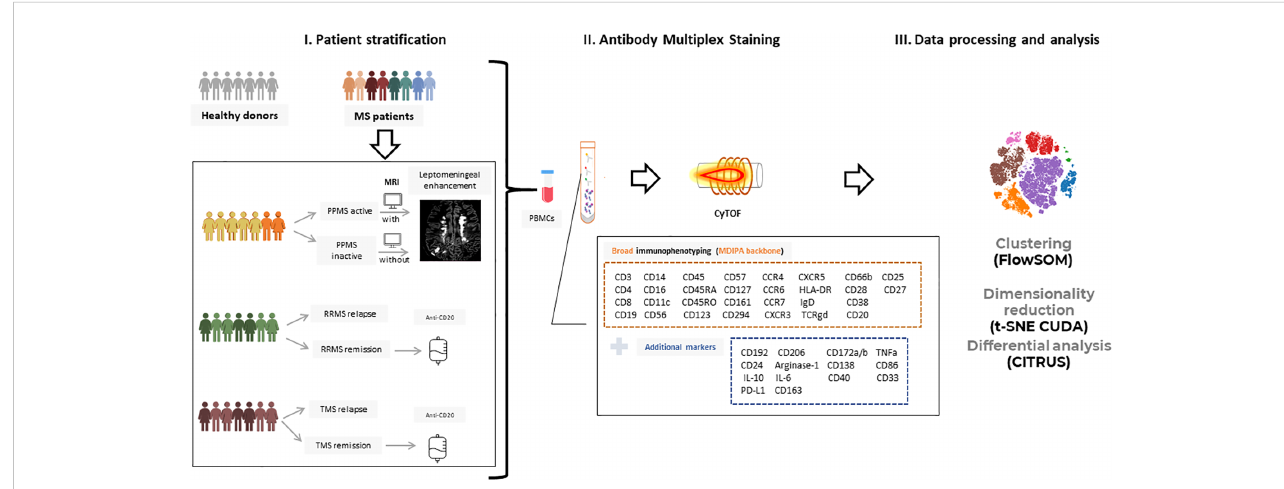
FIGURE 1 Experimental setup and work fl ow for mass cytometry analysis. (I) Peripheral blood mononuclear cells (PBMCs) from patients with Multiple Sclerosis (n=32; PPMS=8, RRMS=10, TMS=14) and healthy donors (n=10) were isolated and further strati fi ed in more subgroups based on clinical and radiological criteria. RRMS and TMS were subgrouped based on disease activity in those during a clinical relapse (RRMS; n=5, TMS; n=5) and those under remission (RRMS; n=4, TMS; n=5). PPMS were subgrouped based on the presence of leptomeningeal enhancement on MRI (active PPMS; at least one foci of leptomeningeal in fl ammation, inactive; without evidence of leptomeningeal in fl ammation based on MRI criteria). (II) PBMCs were labeled with metal- tagged antibodies against the markers shown in boxes and acquired on a Helios mass cytometer. This multiplex analysis allows broad immunophenotyping as well as deeper analysis in B cell and myeloid subpopulations. (III) Acquired data were analyzed using established analysis pipelines for dimensionality reduction and exploratory data analysis, clustering, and differential analysis. PPMS, Primary Progressive Multiple Sclerosis; RRMS, Relapsing Remitting Multiple Sclerosis; HD, Healthy donors; TMS, Tumefactive Multiple Sclerosis; MRI, magnetic resonance imaging; t-SNE, t- distributed stochastic neighbor embedding; FlowSOM, Flow Self-Organizing